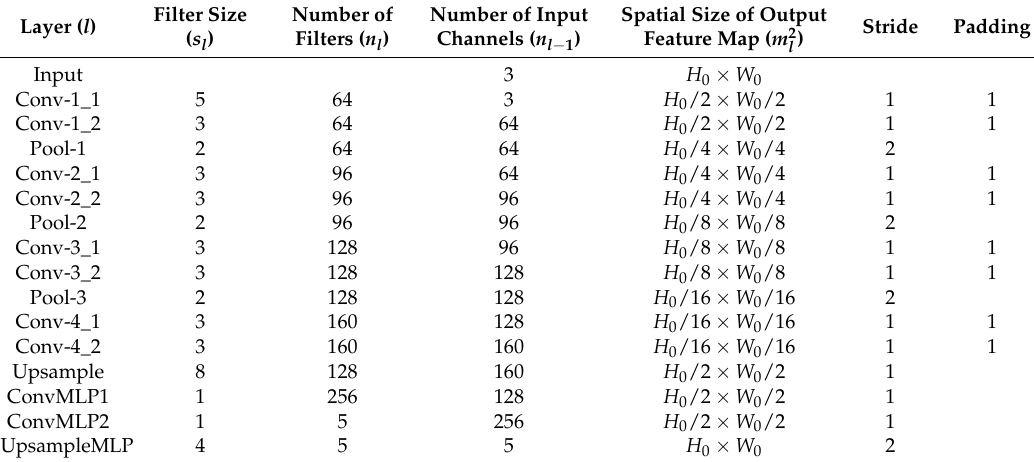
Table 5. Convolutional Layer Parameters of MLP.